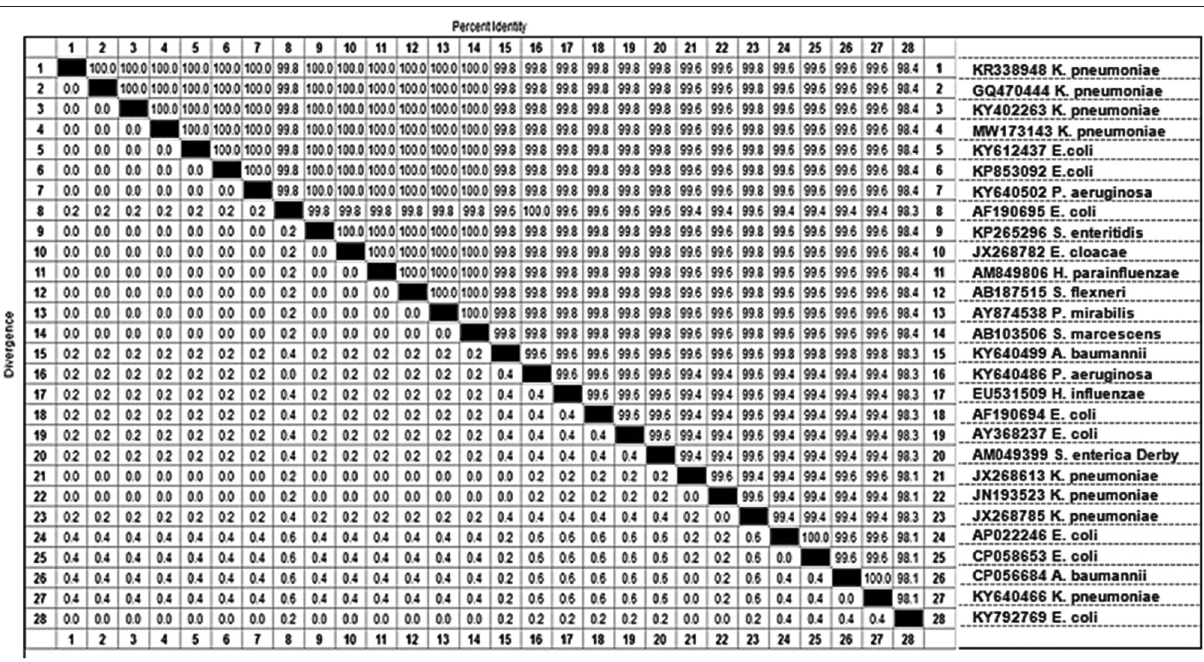
Figure-2: Sequence distance of the bla gene of the test isolate (generated by Lasergene) showing an identity range of TEM 98.4-100% with the bla gene of different test TEM